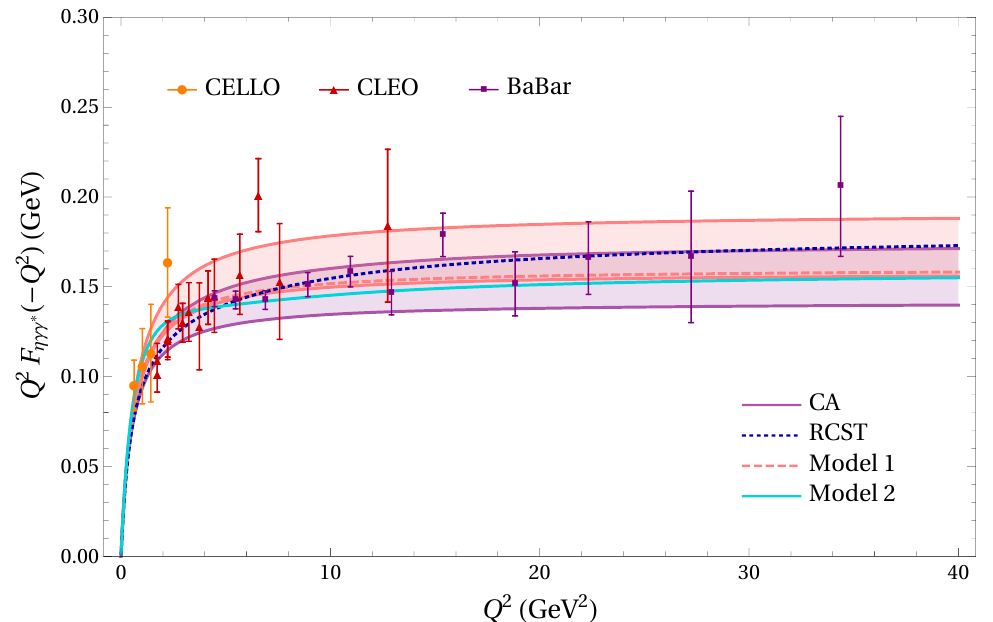
Figure 10. Singly-virtual (cid:17) TFF. The large- N c Regge model, \Model 1" (4.34), is indicated by the pink band with the dashed curve. Our alternative TFF model, \Model 2" (B.1), is indicated by the solid cyan curve. The purple band is the CA result from ref. [49]. The dark blue dotted curve is the RCST result from ref. [125]. The data are from CELLO [115], CLEO [116], and BaBar